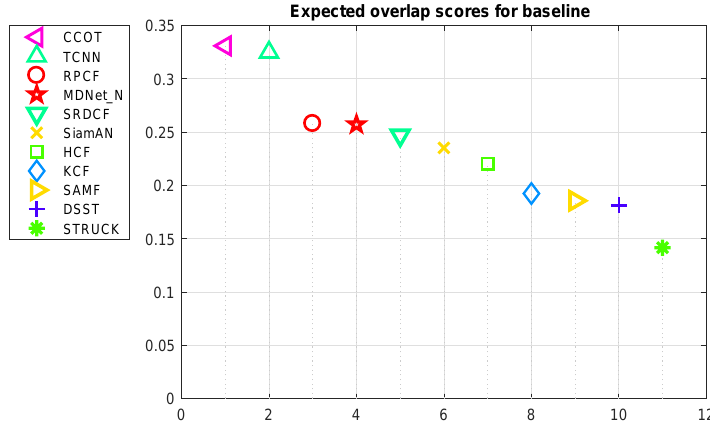
Figure 8. Expected overlap scores in VOT2016 challenge for state-of-the-art